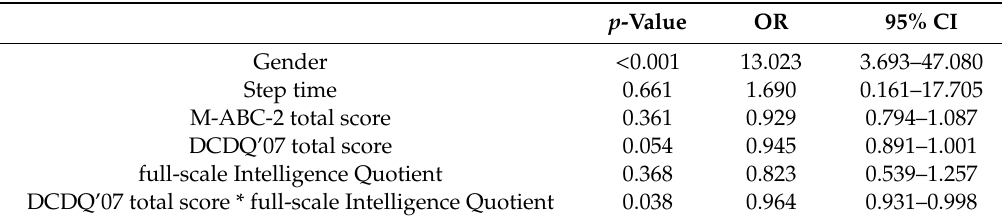
Table 2. Predictors of case-control